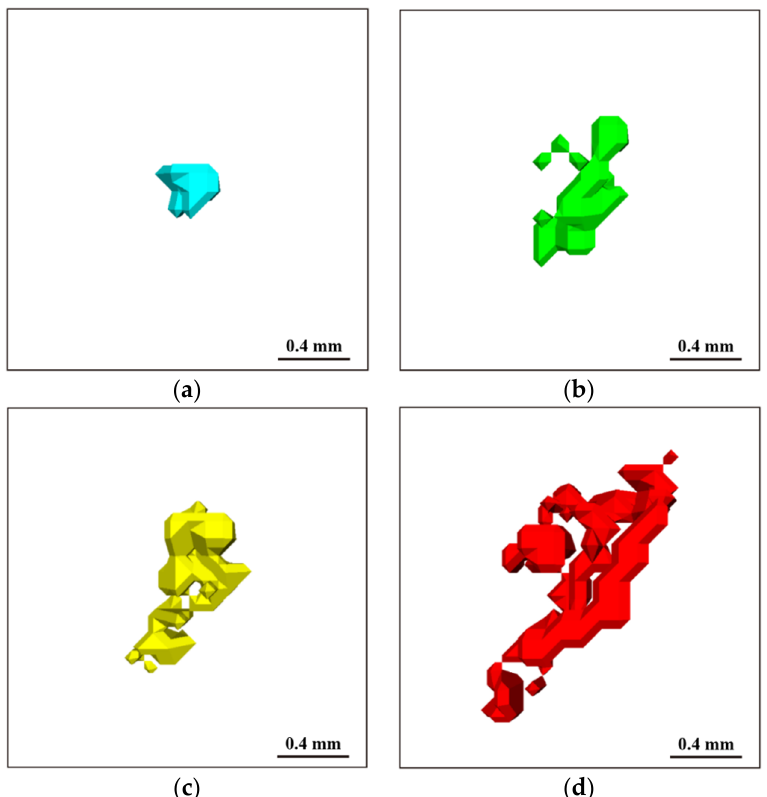
Figure 9. Morphology of the porosities with different sizes: ( a ) Porosity 1; ( b ) Porosity 2; ( c ) Porosity 3; ( d ) Porosity 4. Table 5. Characteristic data of the porosities in Figure 9.